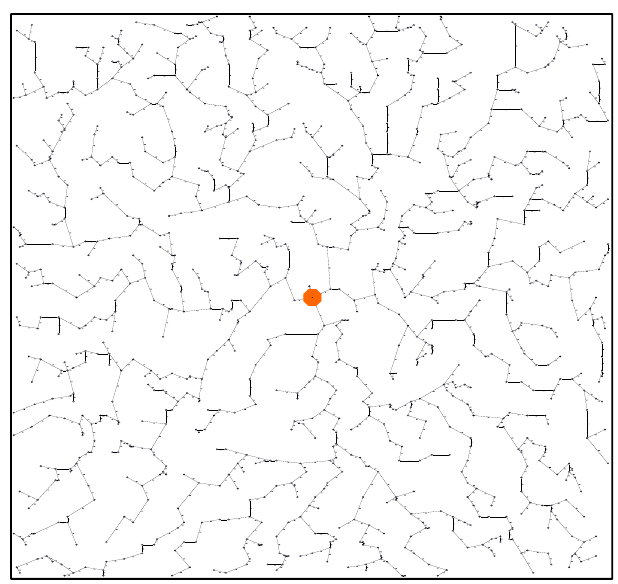
Figure 10. Spanning tree-based routing-enabled WSN generated in WiSer C++.